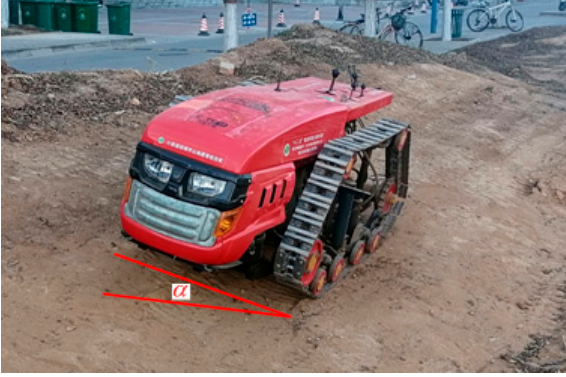
Figure 17. HMT prototype.